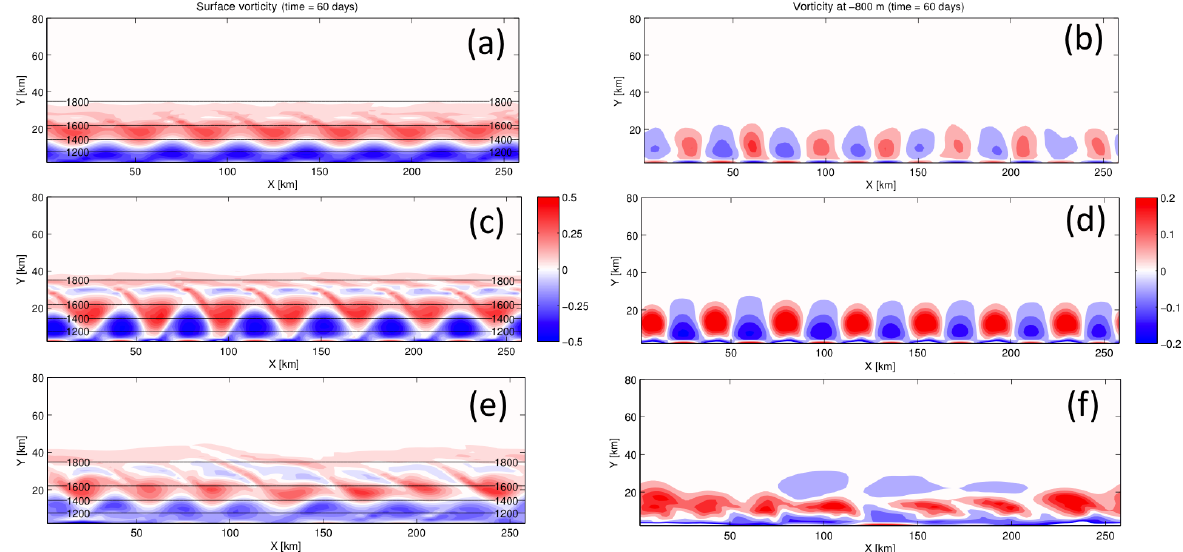
Figure 8. Same as in Fig. 5, but for a shelf slope ( s = 3%, T p = − 0 . 32) when the aspect ratio parameter is γ (cid:39) 0 . 24 ( H = 1300m) and the vortex Rossby number is Ro = 0 . 25. Panels (a, b) , (c, d) , and (e, f) correspond to t = 60, t = 100, and t = 150 days, respectively.